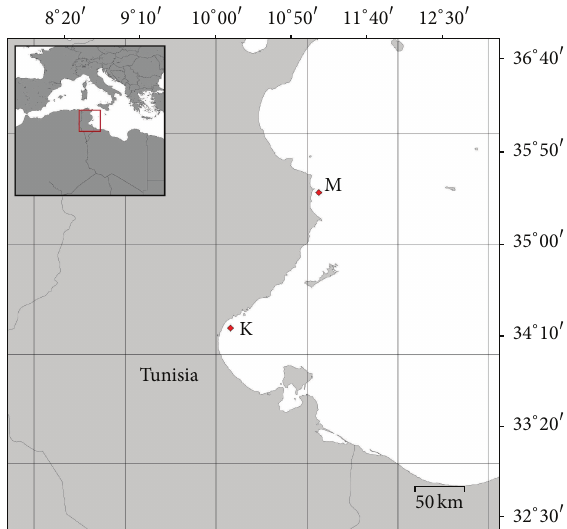
Figure 1: Map of the study area, showing the sampling stations with M, Mahdia (control station), and K, Skhira (disturbed station).